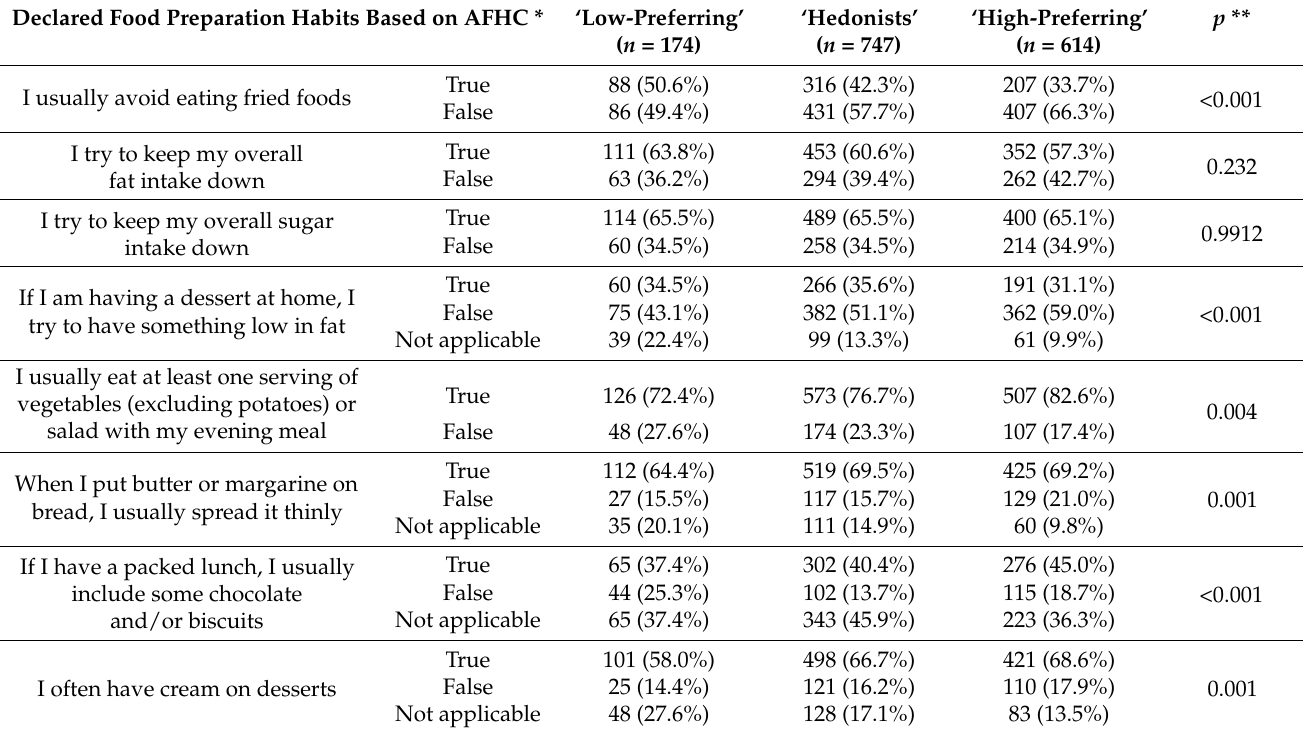
Declared Food Preparation Habits Based on AFHC